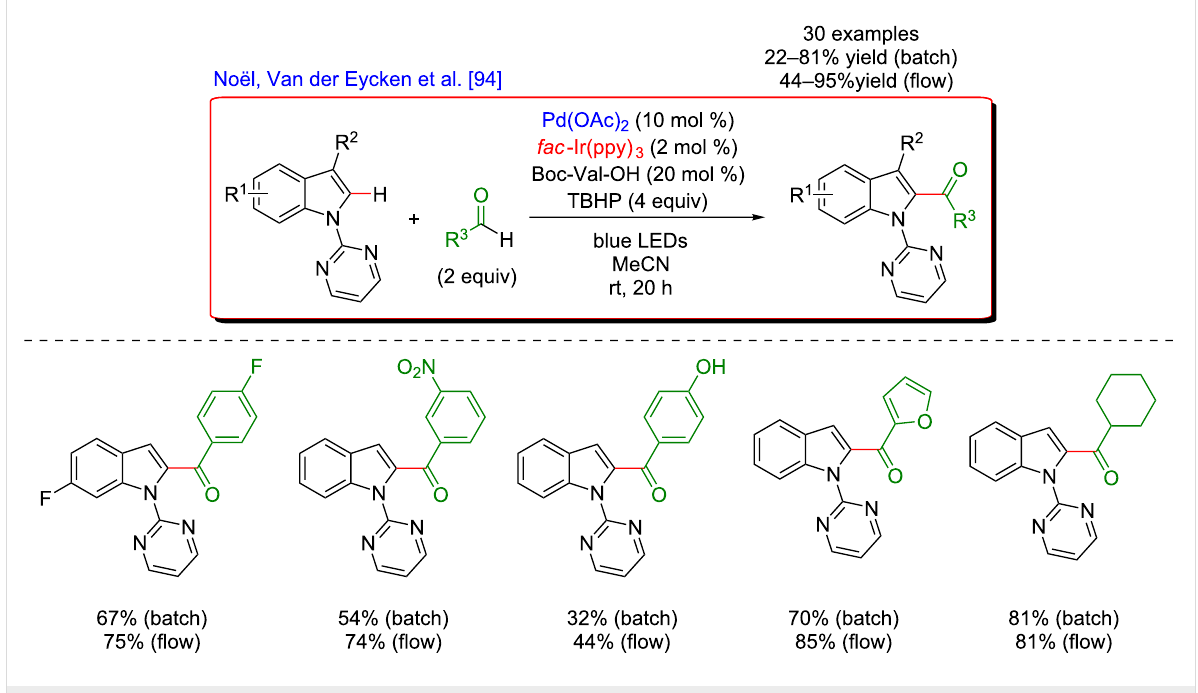
Figure 30: C2-acylation of indoles via the dual C–H activation/photoredox catalysis.